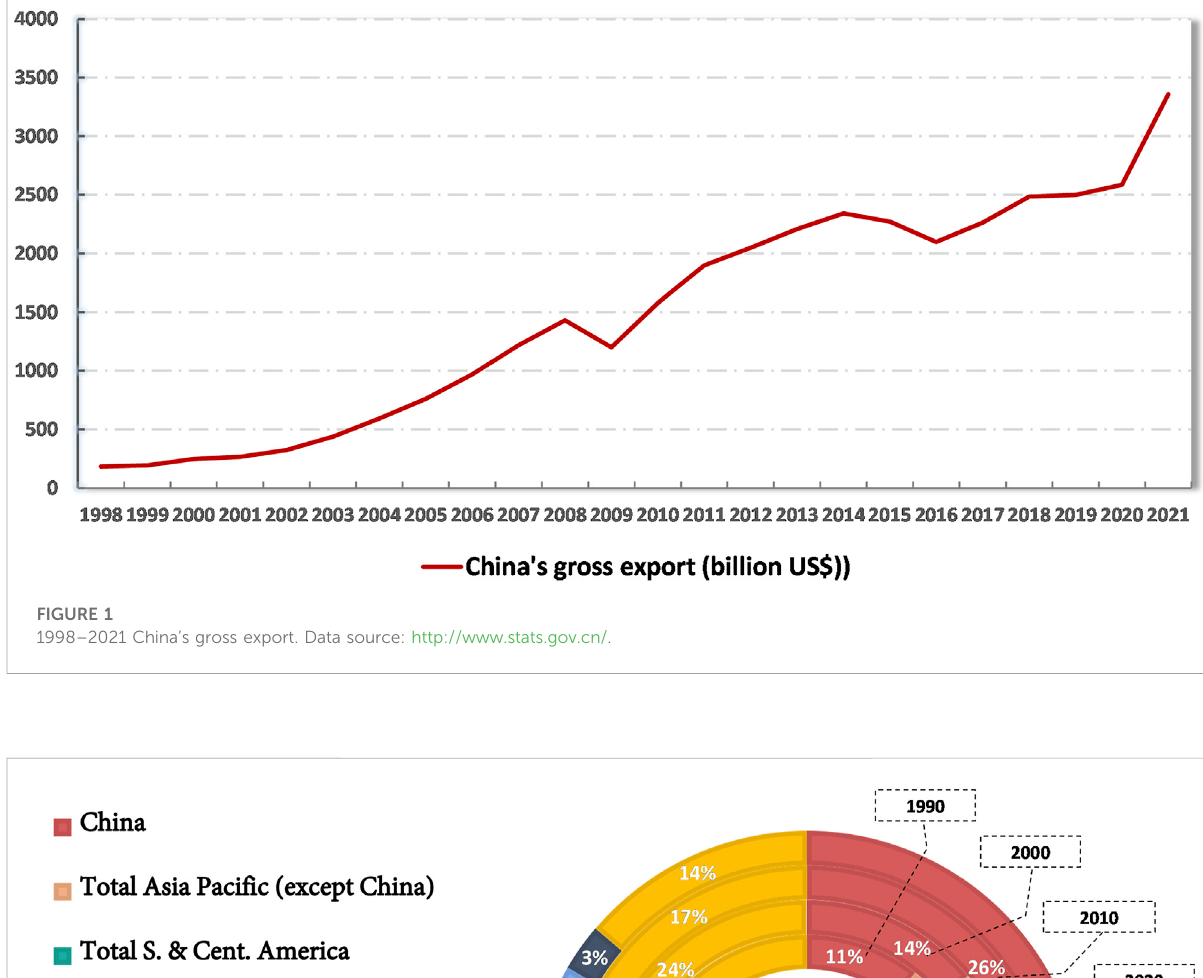
FIGURE 1 1998 – 2021 China ’ s gross export. Data source: http://www.stats.gov.cn/.